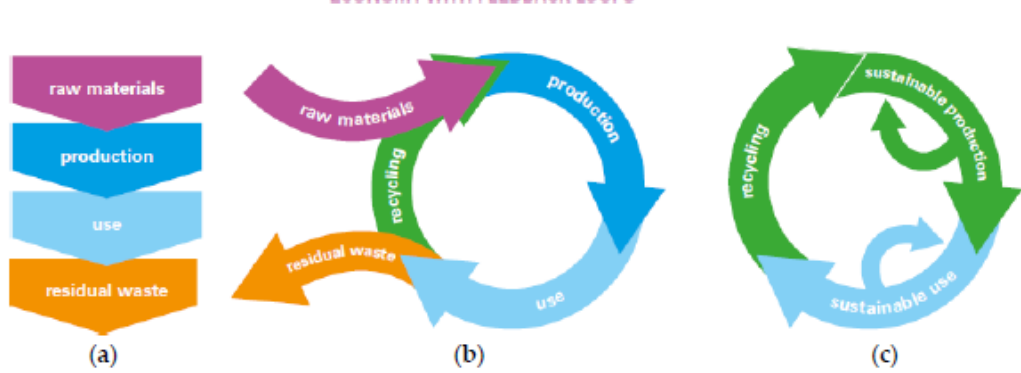
Figure 3. Inflows and outflows diversifications among the schemes of ( a ) linear economy, ( b ) economy with feedback loops, and ( c ) CE. Source: adapted from [85], p. 4/17.